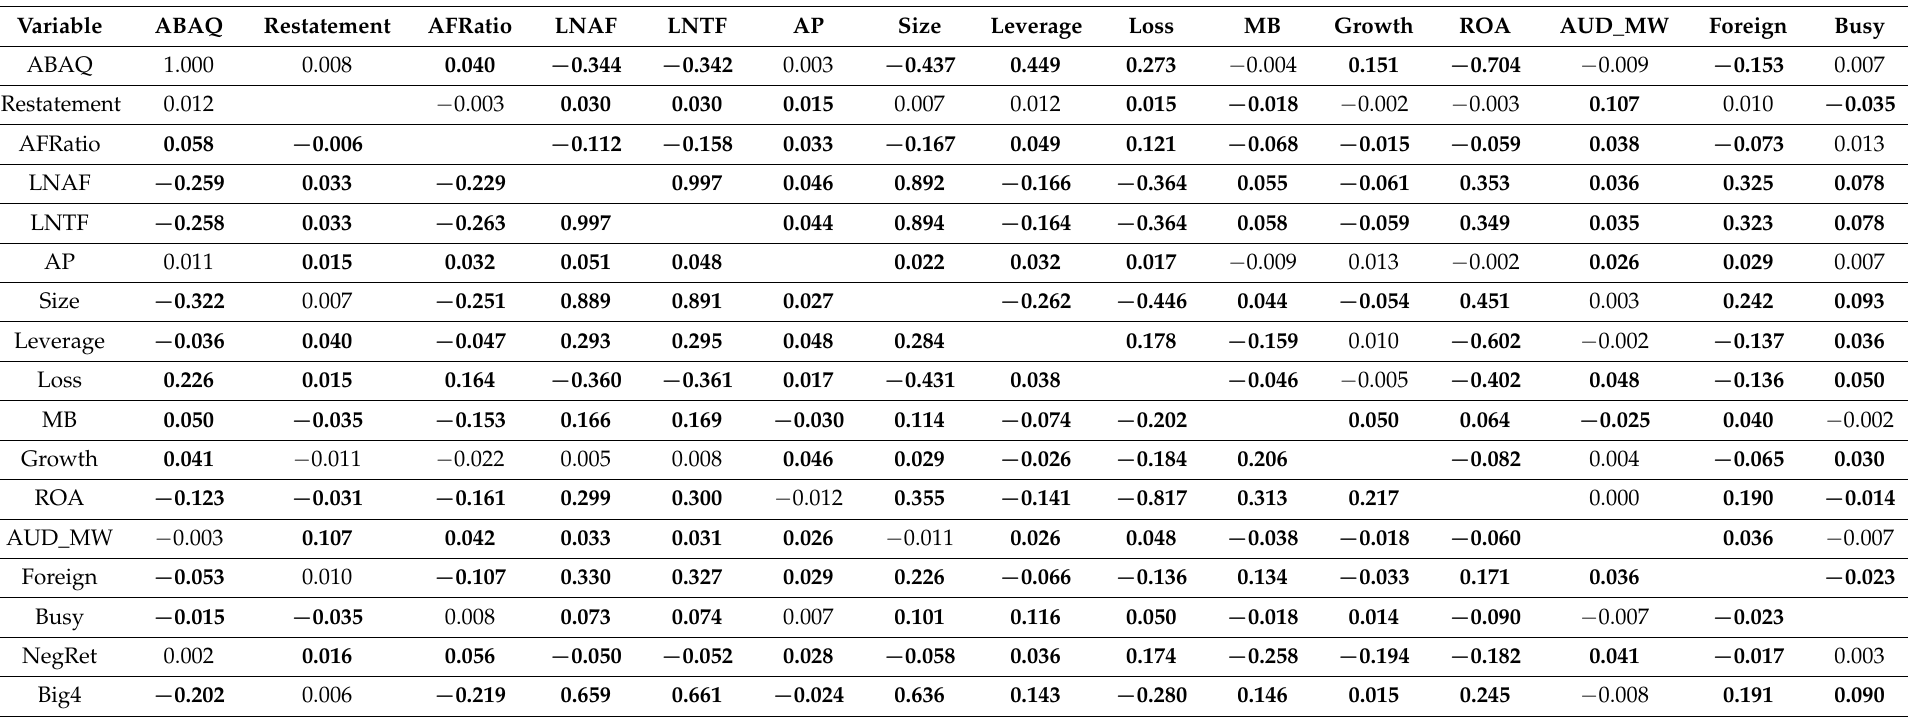
Panel B : Correlations for the three-year balanced panel designed ABAQ, Restatement, and AF of U.S. sample